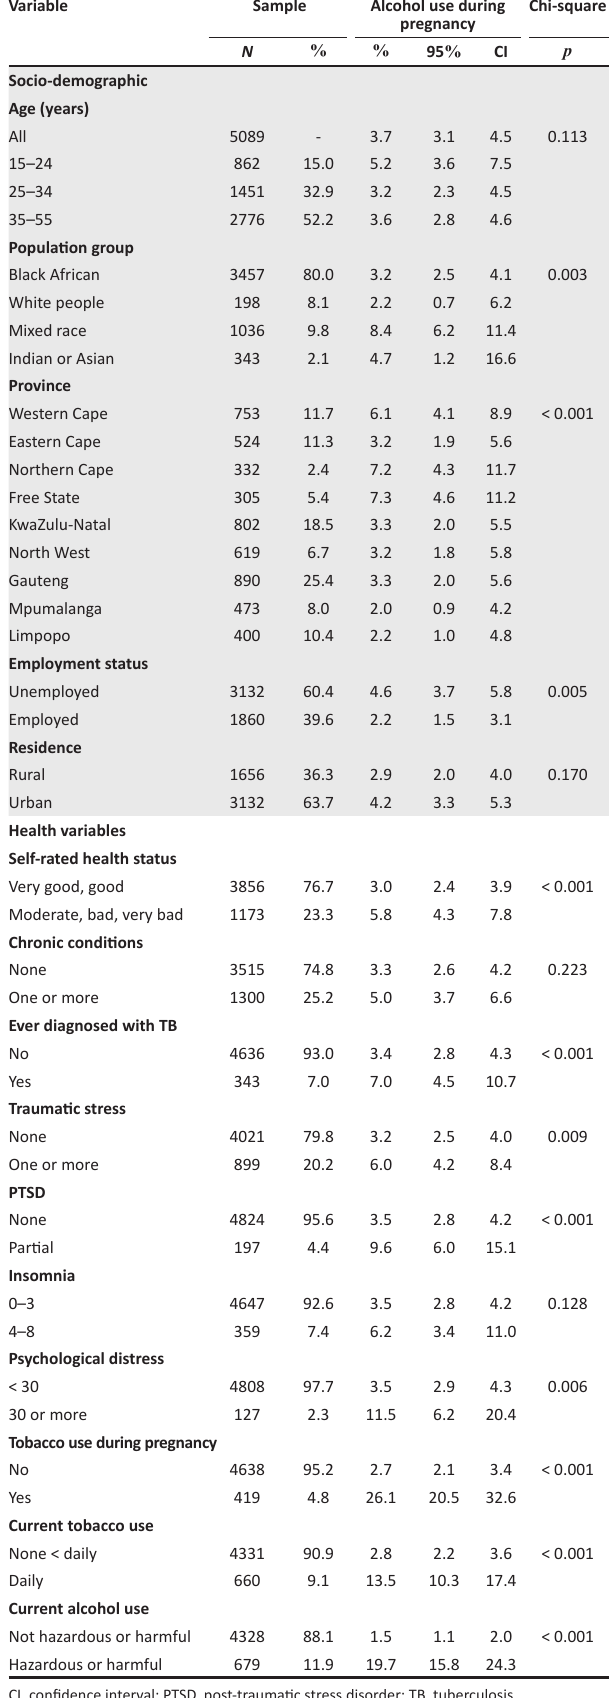
TABLE 1: Sample characteristics and weighted prevalence of alcohol use during pregnancy. Variable Sample Alcohol use during